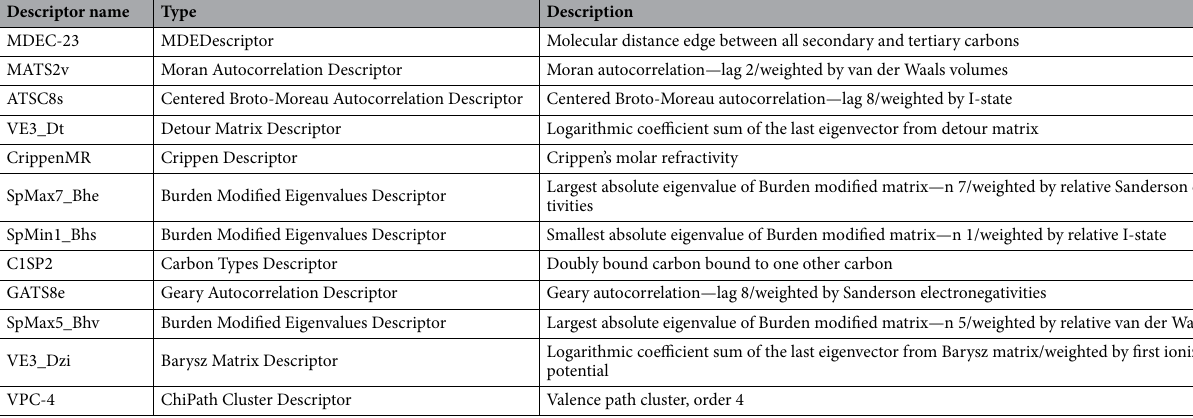
Table 4. Name, type, and description of selected 13 features determining the toxicity of a